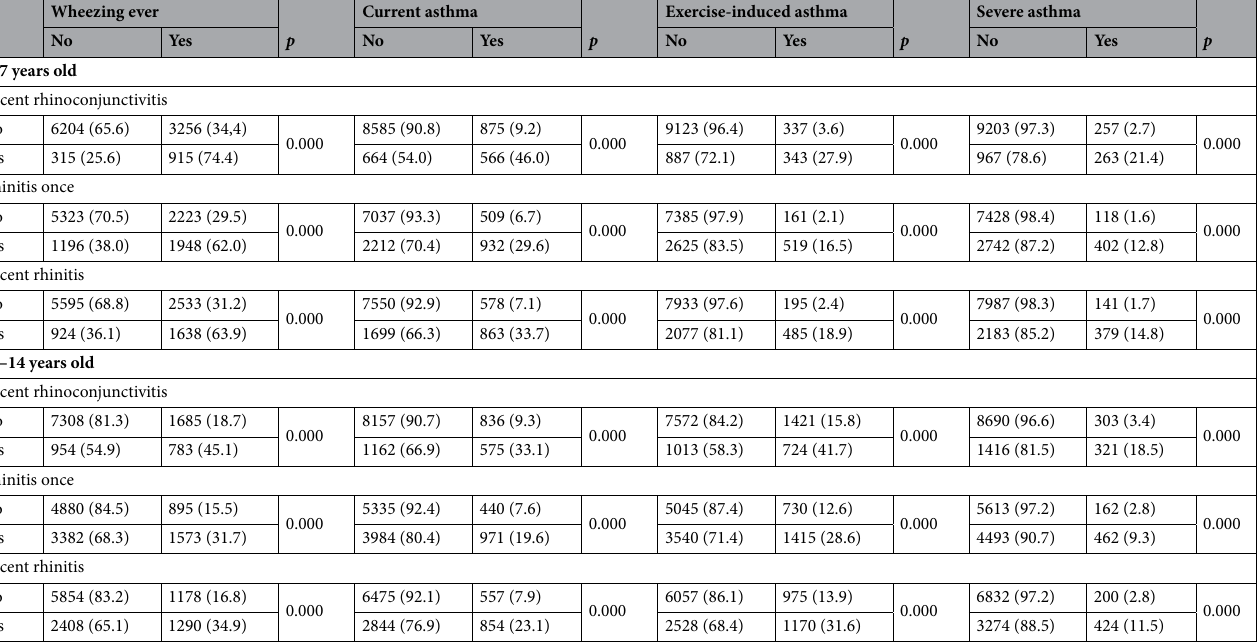
Table 3. Prevalence of asthma symptoms according to rhinitis. Univariate analysis. Data shown as number of cases ( n ) and percentage (%); *Recent refers to the previous 12 months.